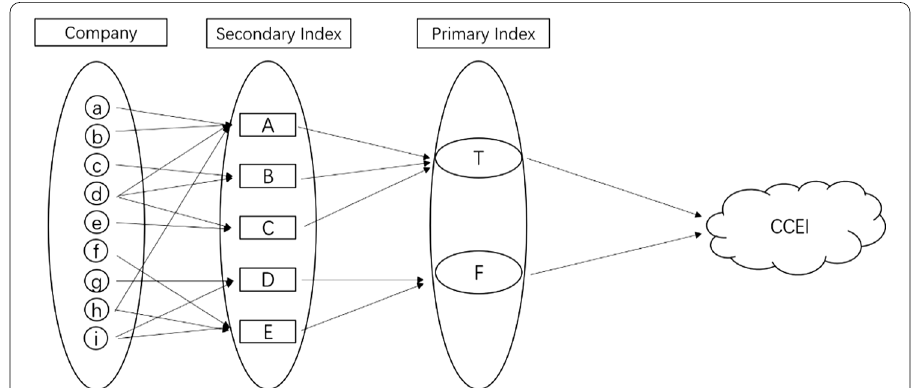
Fig. 1 Mapping relationship between CCEI and its sub indicators to listed enterprises. Note T and F refer to 2 First-level indices, A–E refer to 5 s-tier indices, and a–i refer to 9 enterprises